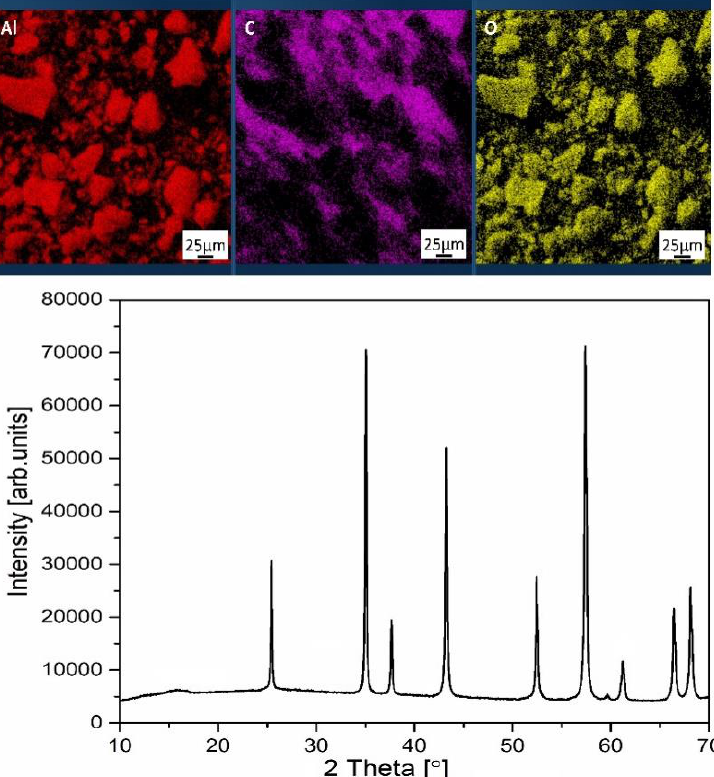
Figure 3. Representative SEM – EDS elemental distribution maps for aluminium, carbon and oxygen ( top ) and XRD pattern ( bottom ) for ceramic-polymer mixture with 50 vol.% of Al 2 O 3 . The FTIR spectra of the raw powders and the 50Al 2 O 3 /50PLA mixture are shown in Figure 4. The characteristic peaks of aluminum oxide and polylactide are clearly visible on the graph, even in the sample with minimal ceramic content. No additional elements and compounds were detected. Thus, there was no contaminations or appearance of the new phases during the mixing process.